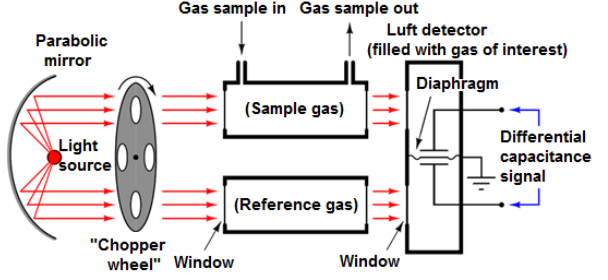
Fig. 7. NDIR gas analyzer working principle – prepared basing on